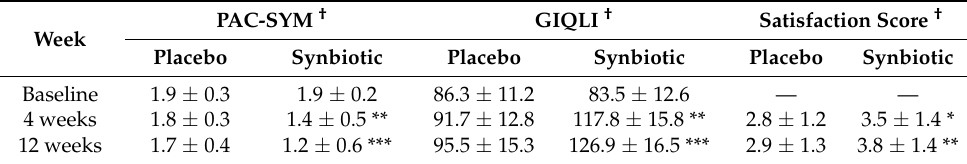
Table 3. Efficacy endpoints.